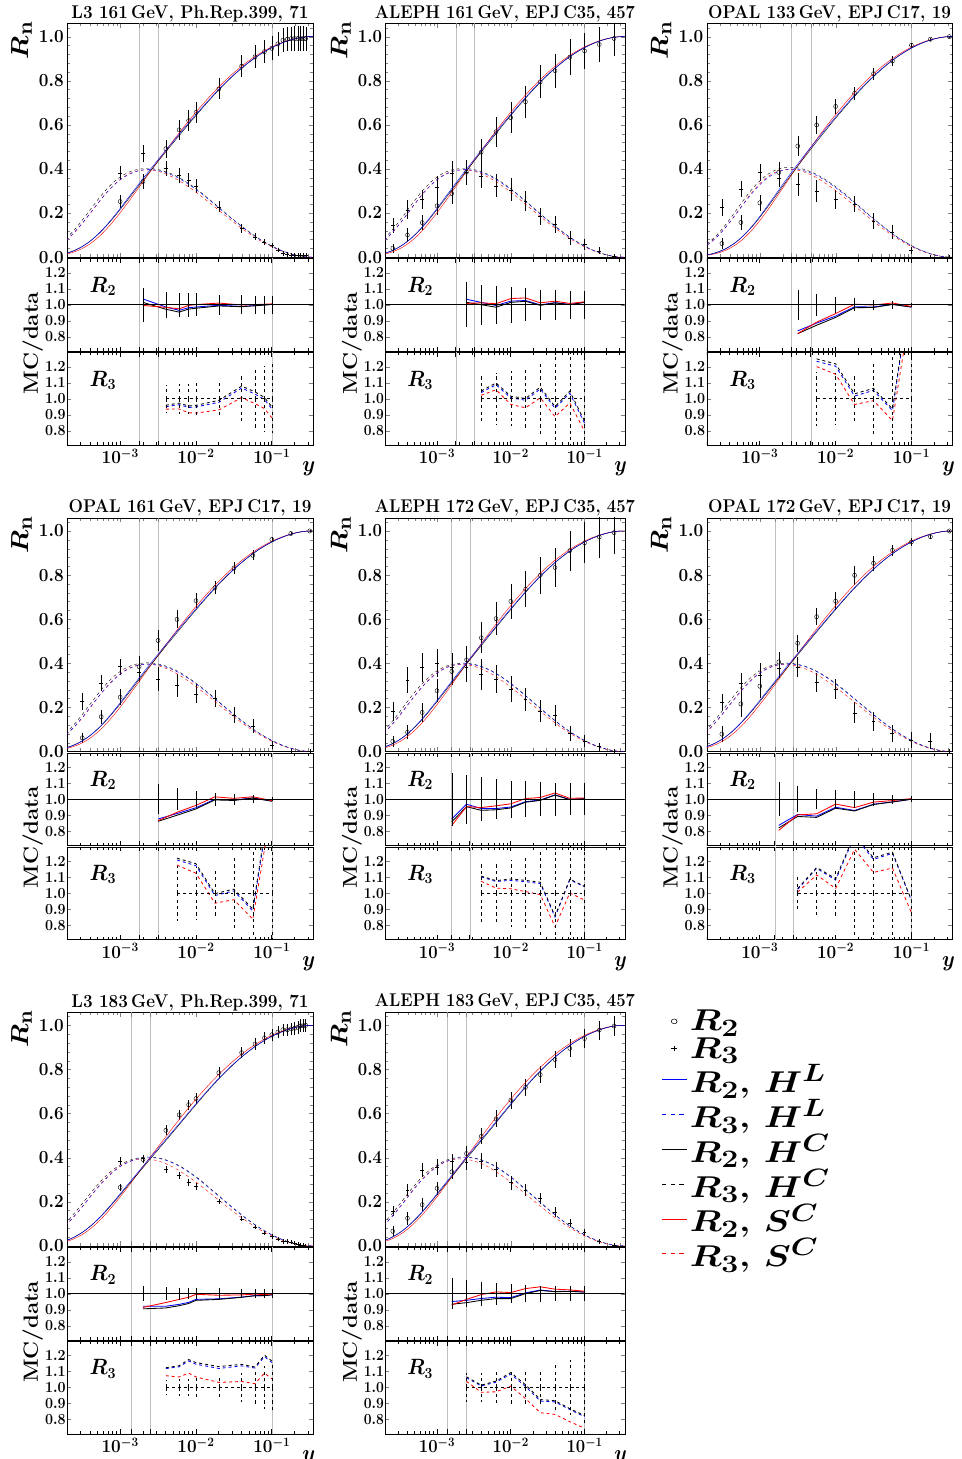
Figure 10 . Predictions obtained with S C , H C and H L MC setups at hadron level.